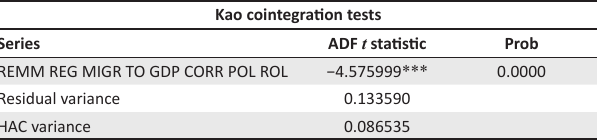
TABLE 4b : Unit root and cointegration tests. TABLE 5: Combined regression